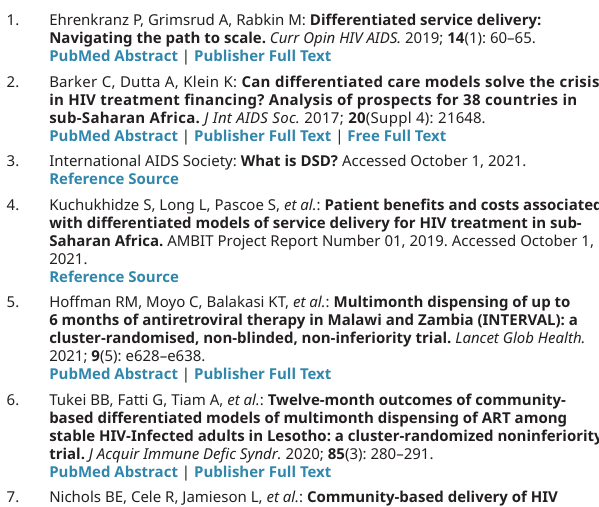
Figure. 2021. http://www.doi.org/10.6084/m9.figshare.17096678.v